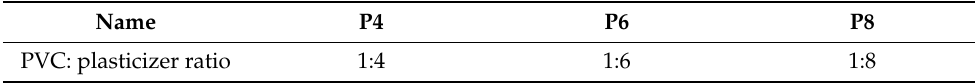
Table 2. PVC gel composite weight ratios and naming convention.